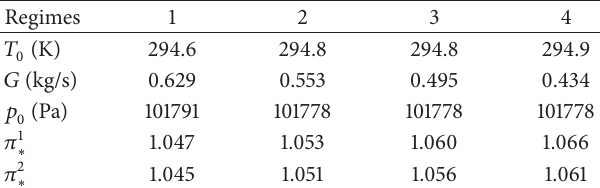
Table 1: Experimental data for regimes 1–4.